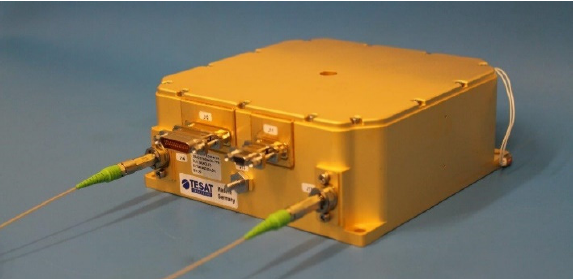
Figure 5. TESAT RLU (Image credit: TESAT Spacecom).